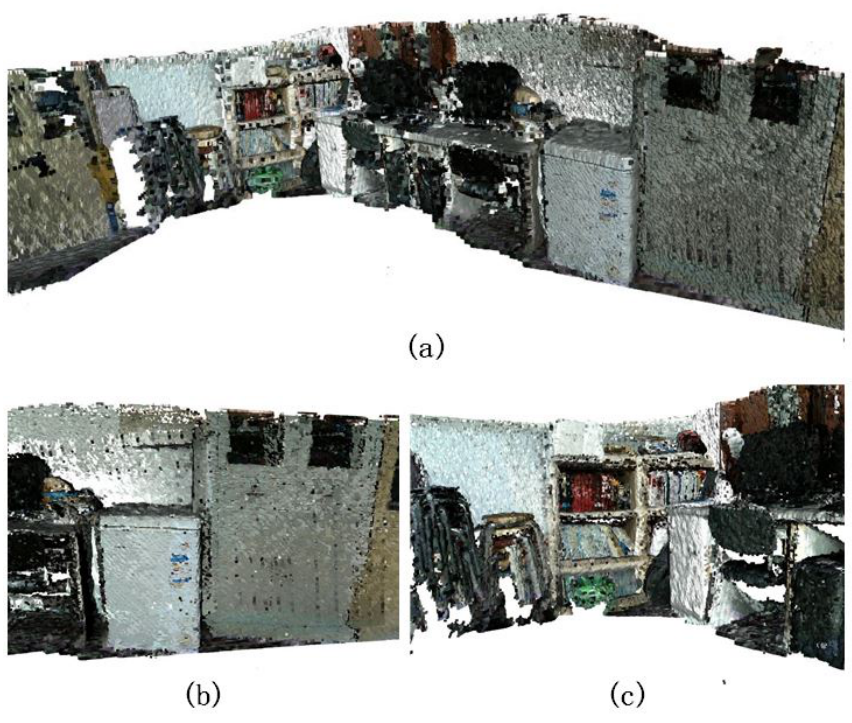
Figure 7. The results of reconstruction of the office. ( a ) The whole scene of the office. ( b , c ) Different parts of the